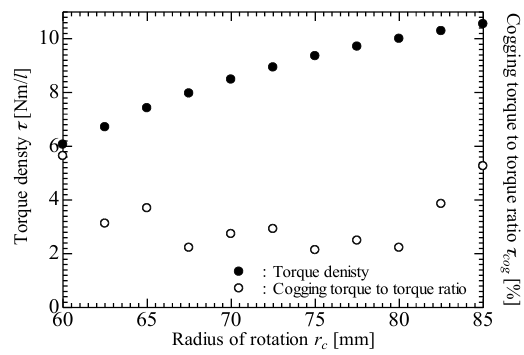
Figure 12: Characteristics of cogging torque to torque ratio and torque density against radius of rotation.